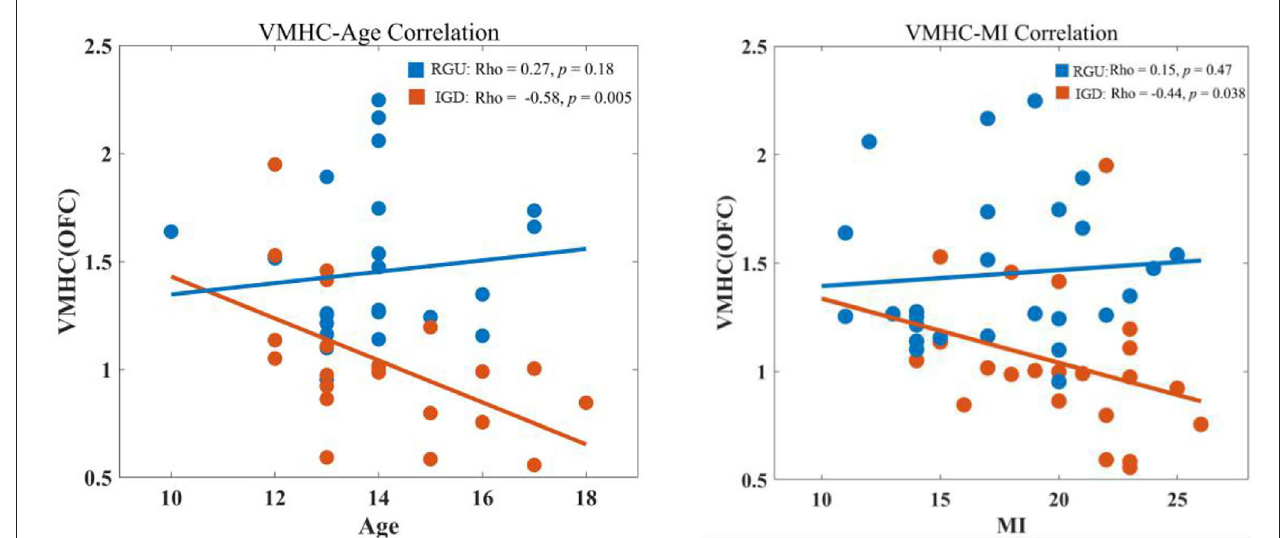
FIGURE 3 | Correlation analysis of VMHC value with age and MI. The left shows the correlation analysis between age and VMHC values of the two groups. The right shows the correlation analysis between the MI and VMHC values of the two groups.